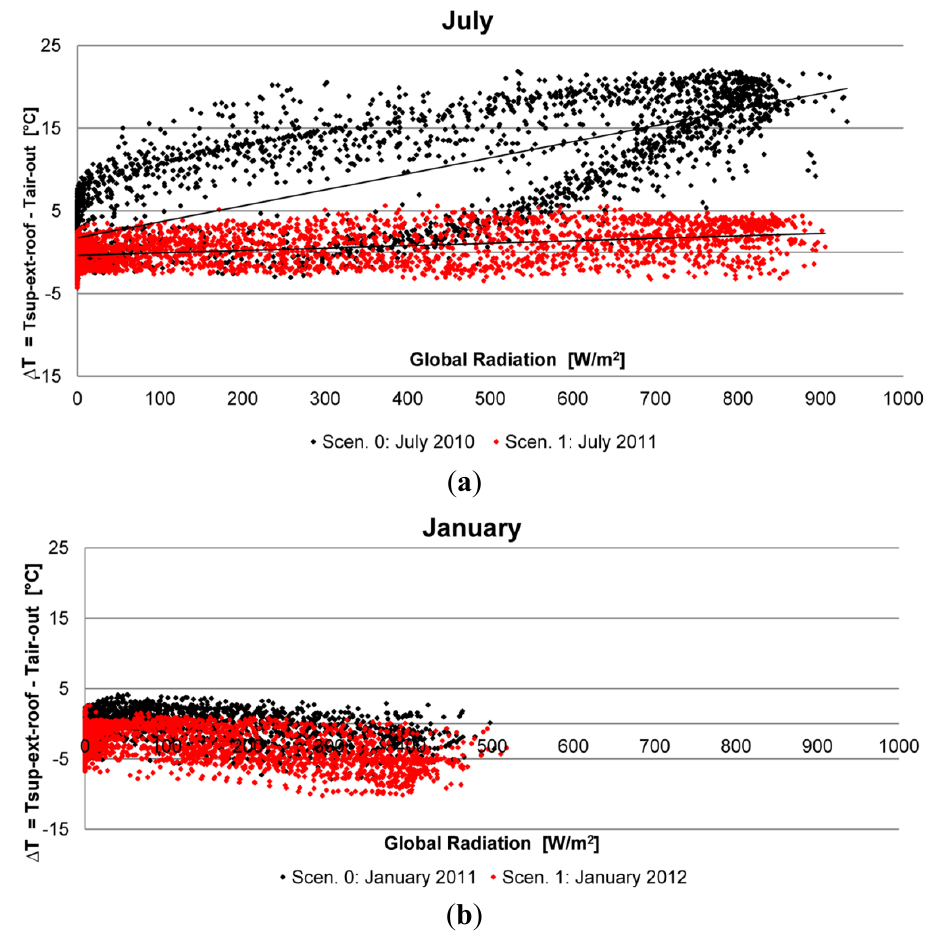
Figure 6. Roof overheating with respect to the global radiation of the location in ( a ) July and ( b